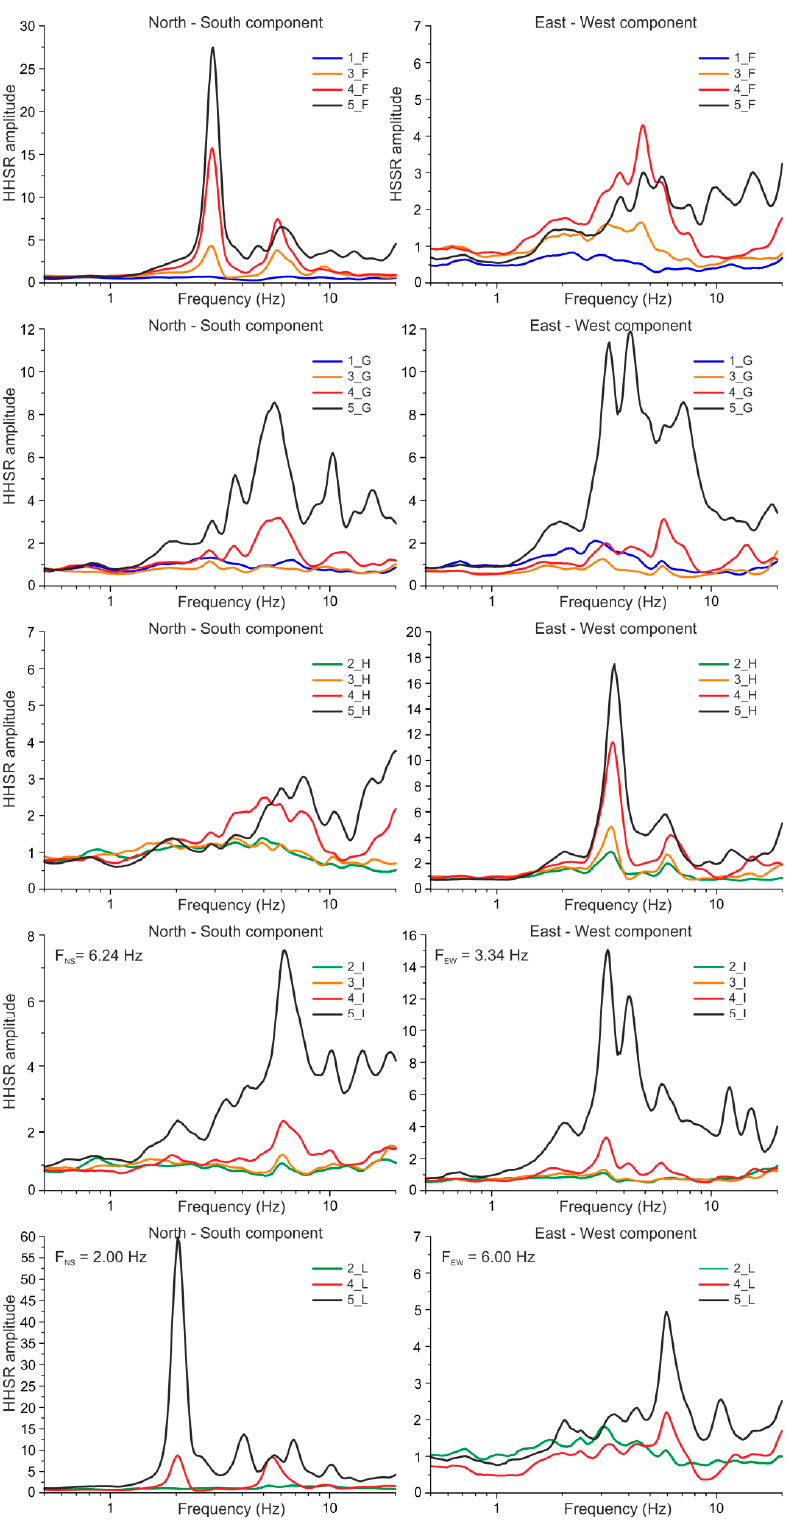
Figure 5. HHSR plots obtained from noise recordings performed at floors one (basement) to five (roof) for the sites F, G, H, I, and L.